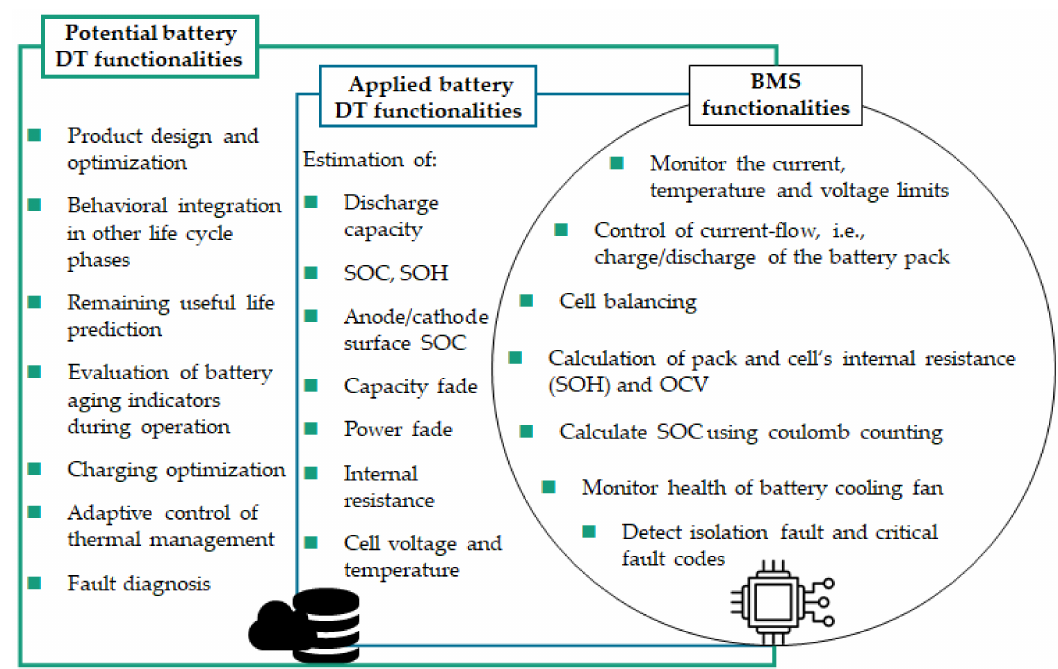
Figure 1. Comparison of BMS functionalities with the applied battery DT and the potential battery DT